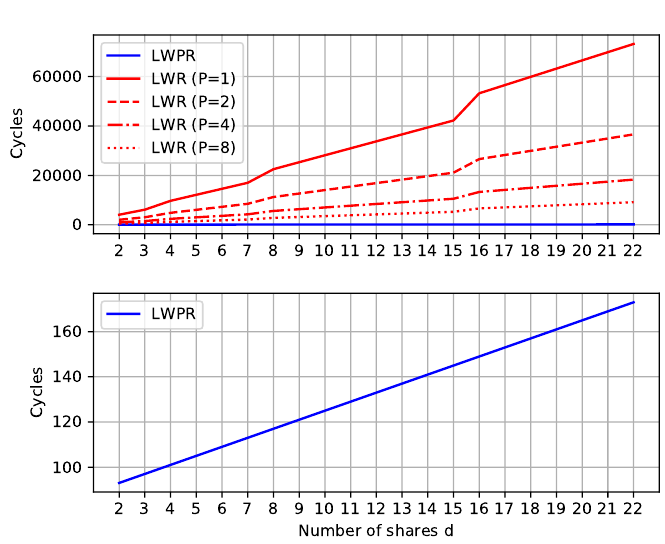
Figure 9: Latency in function of the number of